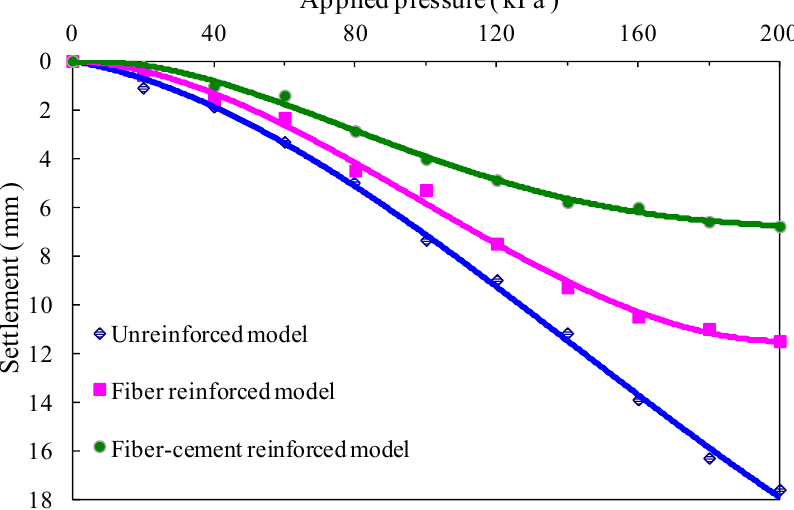
Figure 8. Comparison of applied surface pressure-settlement curves of the top surface for three Figure 8. subgrade models.